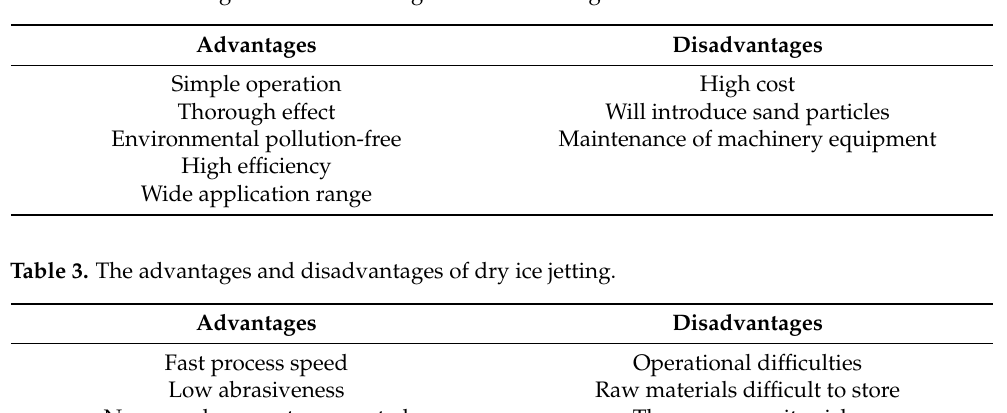
Table 2. The advantages and disadvantages of sandblasting.